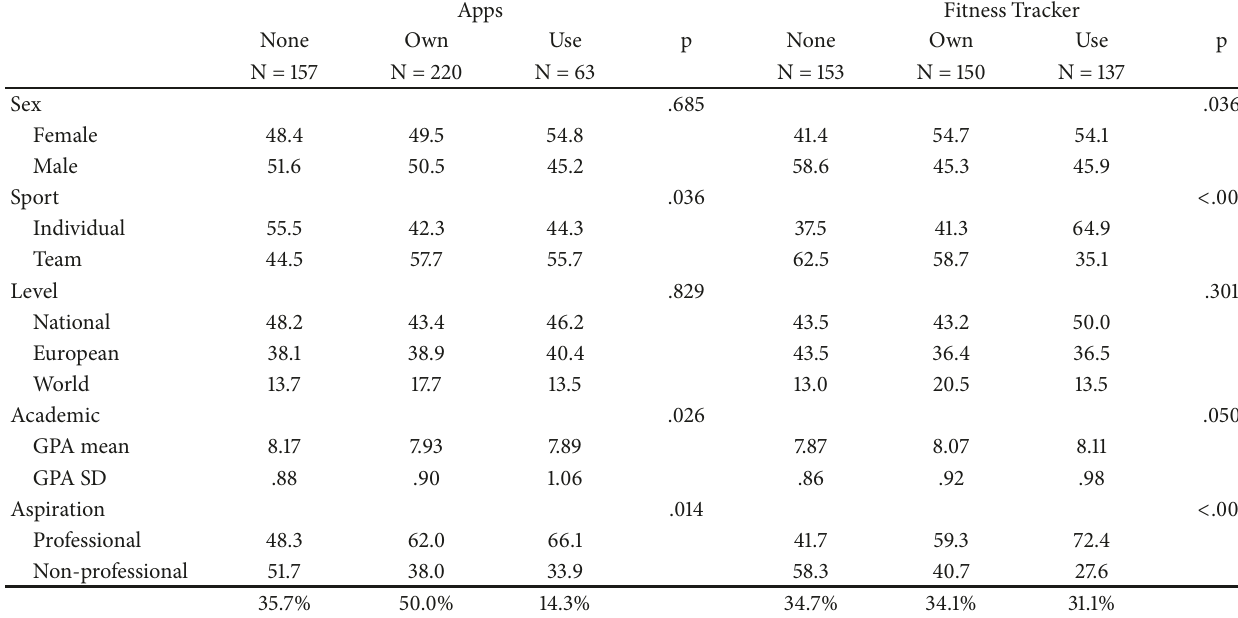
Table 1: Sample characteristics (%) and chi-square test of